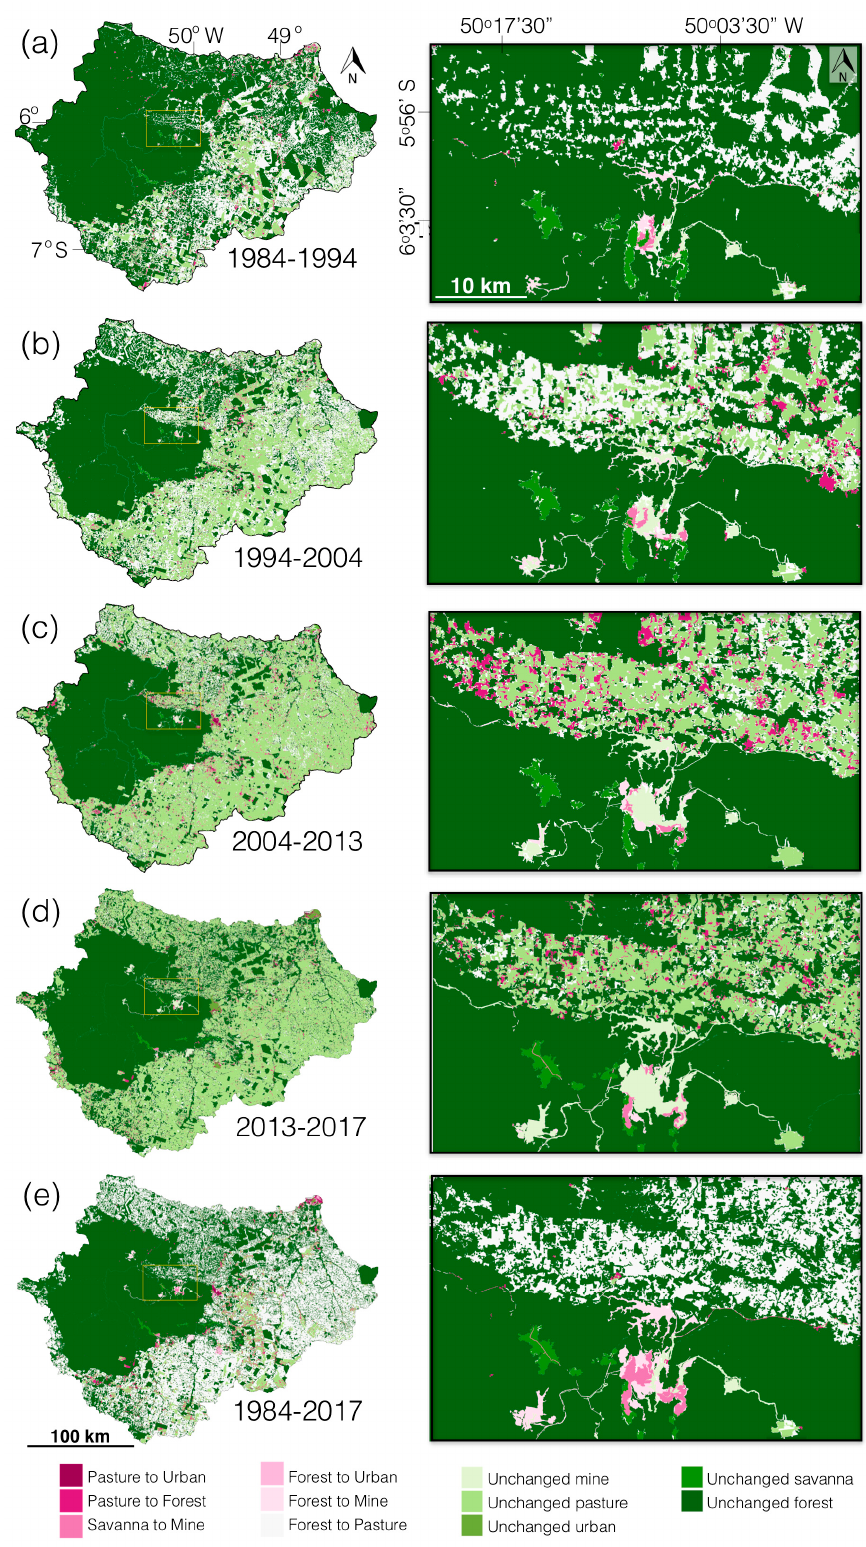
Figure 7. ( Left ) Distribution of LCLU changes from the object-based approach during the periods 1984–1994 ( a ) 1994–2004 ( b ) 2004–2013 ( c ) 2013-2017 ( d ) and 1984–2013 ( e ) in the IRW. ( Right ) Detailed maps illustrating LCLU changes using the “from-to” change detection approach.